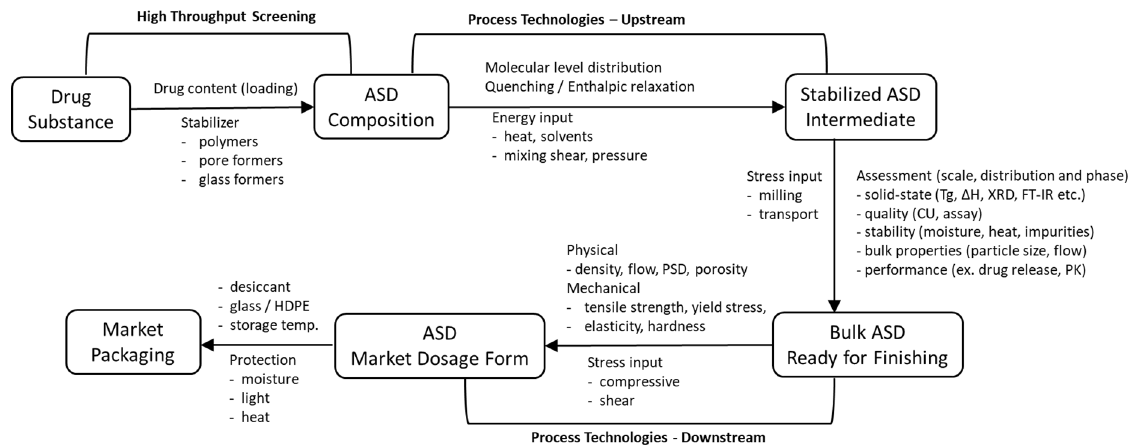
Figure 7. Stages in pharmaceutical development of ASD-based market and clinical formulation.